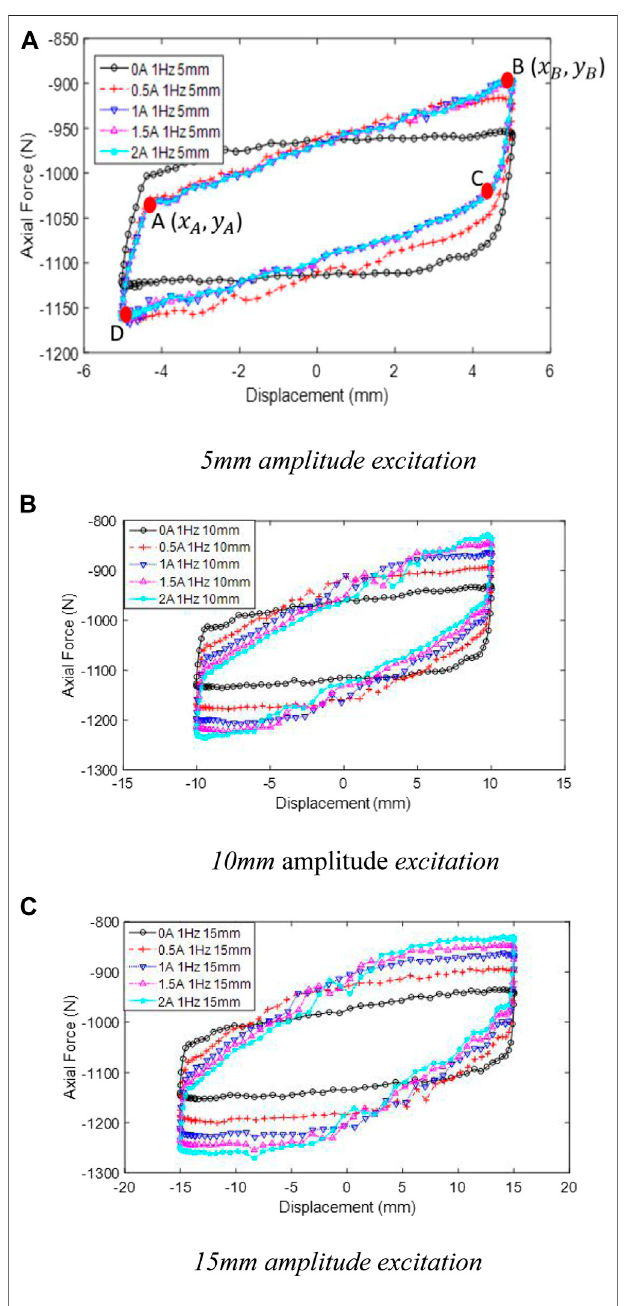
FIGURE 5 | Force-displacement loops under different currents and amplitudes. (A) 5 mm amplitude excitation. (B) 10 mm amplitude excitation . (C) 15 mm amplitude excitation